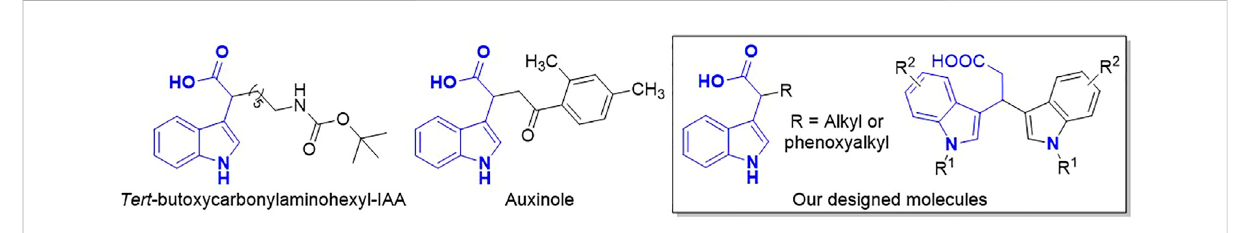
FIGURE 2 Reported structures of TIR1 antagonists and our designed